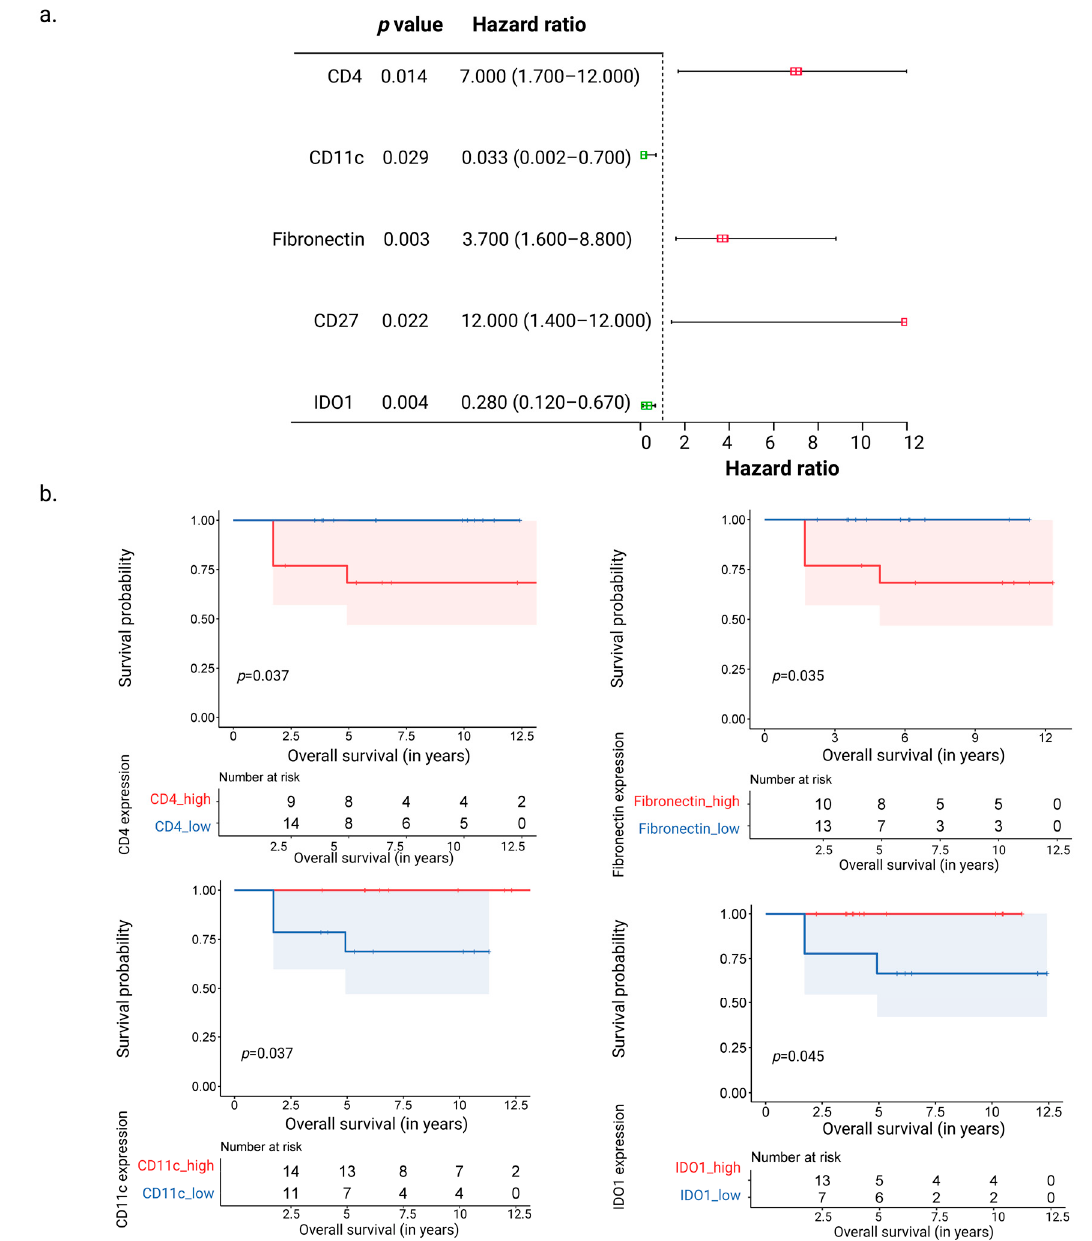
Figure 3. Correlation of the most significant genes between groups and survival. ( a ) Forest plot showing the proteins associated positively (CD4, CD27, and Fibronectin) and negatively (CD11c and IDO1) with hazard ratios associated with overall survival, as seen after Cox regression analysis. ( b ) Kaplan–Meier plots showing the proteins (CD4, Fibronectin, CD11c, and IDO1) associated with the overall survival probability.